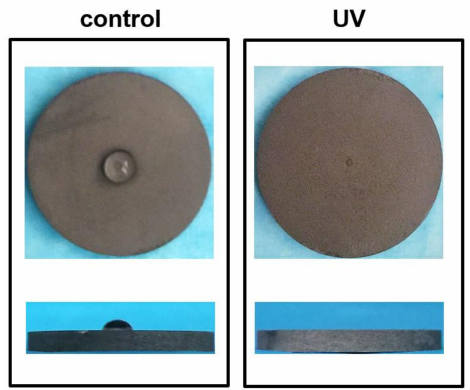
Figure 1. Hydrophobicity / hydrophilicity status of titanium surfaces. Top- and side view images of 10 µ L double-distilled H 2 O placed on titanium disks. The control titanium surface showed hydrophobic status, whereas the UV-treated surface showed superhydrophilic status.